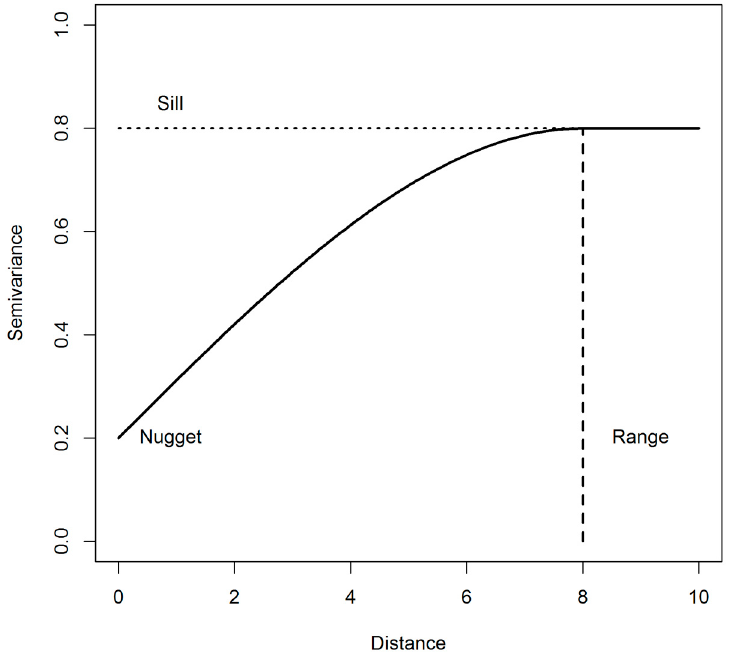
Figure 1. Example of a typical variogram produced from plotting semivariance versus lag distance. Locations of nugget, range, and sill are shown.